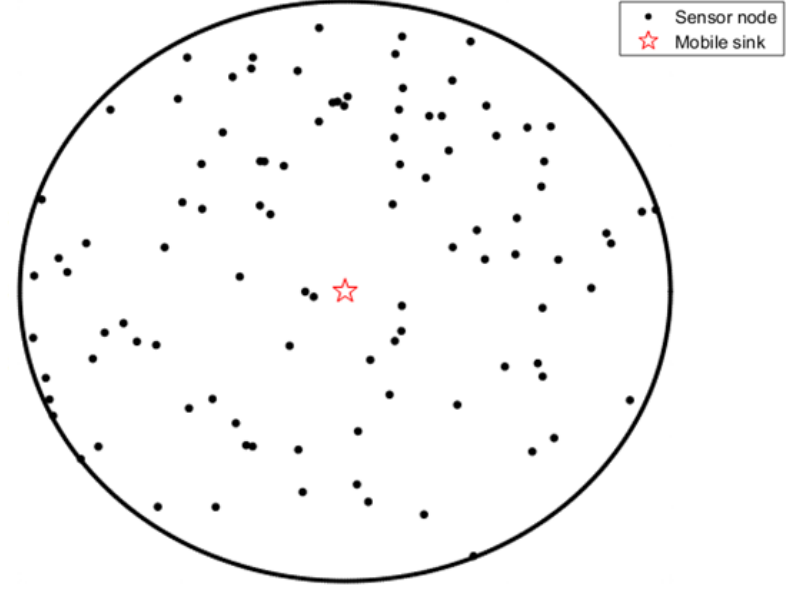
Figure 1. Network model.